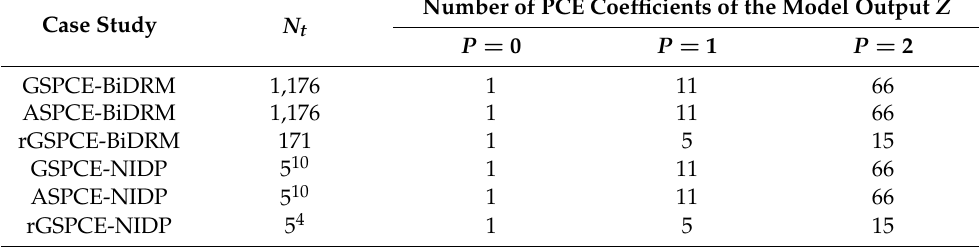
Table 3. Summary of the number of PCE coefficients of Z and the number of evaluations to solve